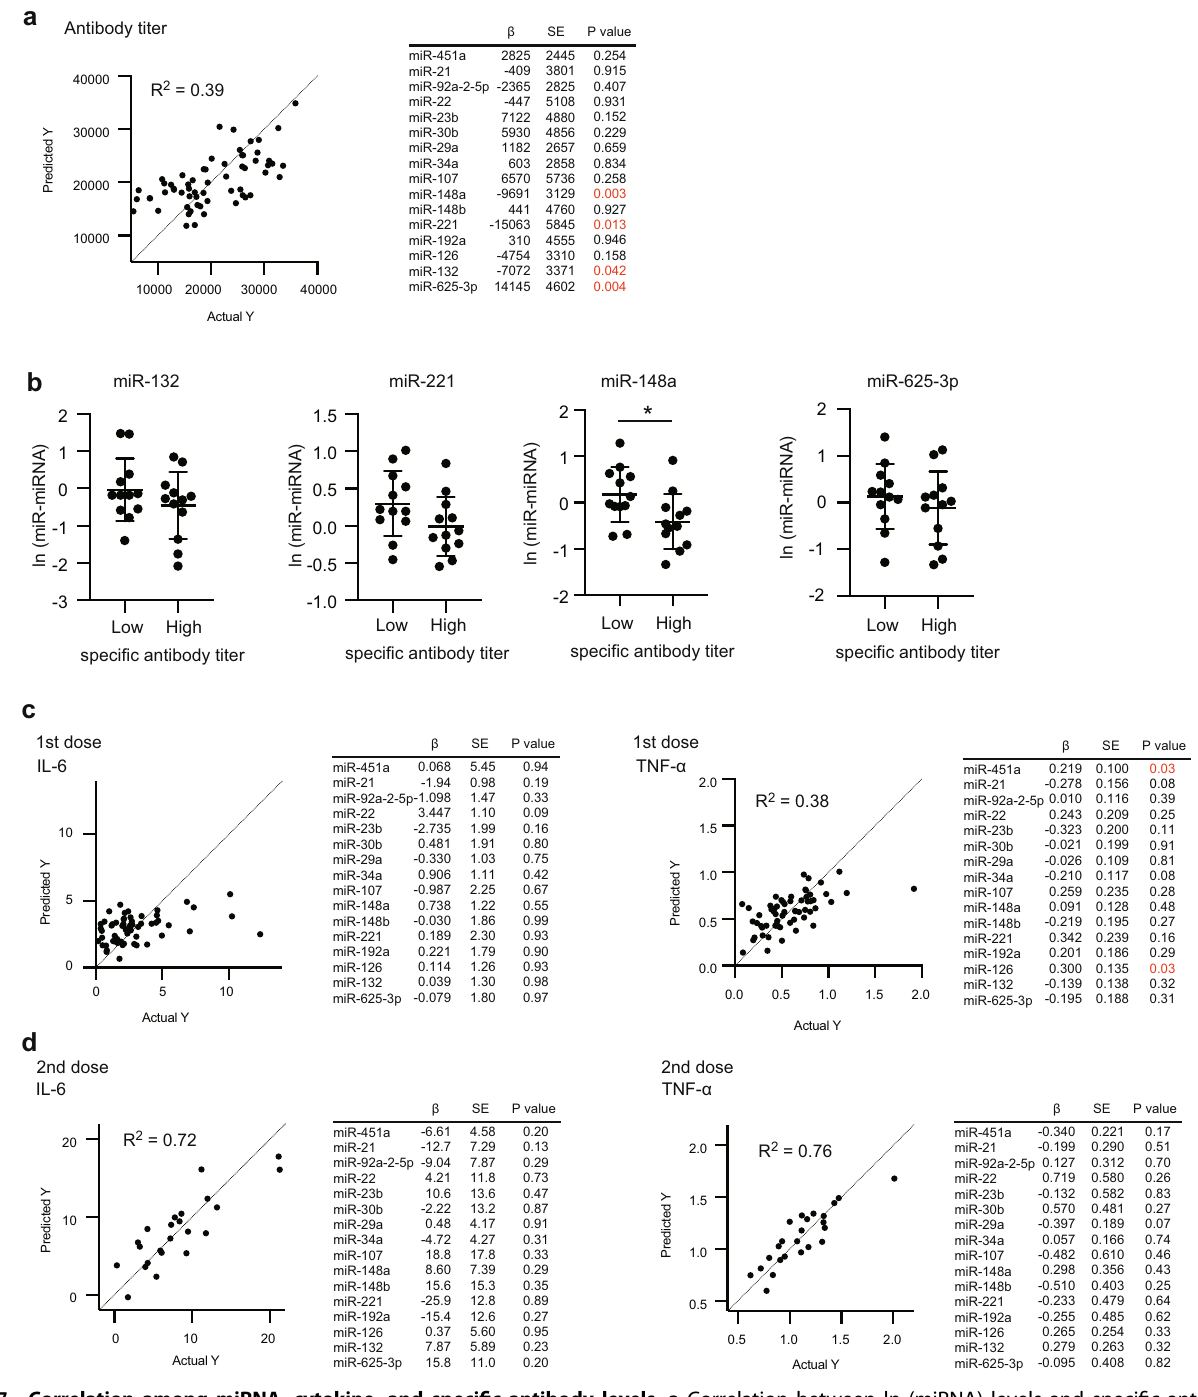
Fig. 7 Correlation among miRNA, cytokine, and speci fi c antibody levels. a Correlation between ln (miRNA) levels and speci fi c antibody titers was investigated via multiple-regression analysis. Multiple coef fi cients of determination (R 2 ) were calculated. The table shows the coef fi cient ( β ), standard error (SE), and p -values of each ln (miR). b ln (miR-132), ln (miR-148a), ln (miR-221), and ln (miR-625-3p) levels were compared between a group with a high speci fi c antibody titer (top 20%) and that with a low level (bottom 20%). Each dot represents a subject (* p < 0.05, t -test). The bars represent mean ± SD. c , d Correlation between ln (miRNA) levels and cytokine levels 1 day after the fi rst ( c ) or second ( d ) doses was investigated by multiple linear-regression analysis. Multiple coef fi cients of determination (R 2 ) were calculated. The tables show coef fi cient ( β ), standard error (SE), and p -values of each ln